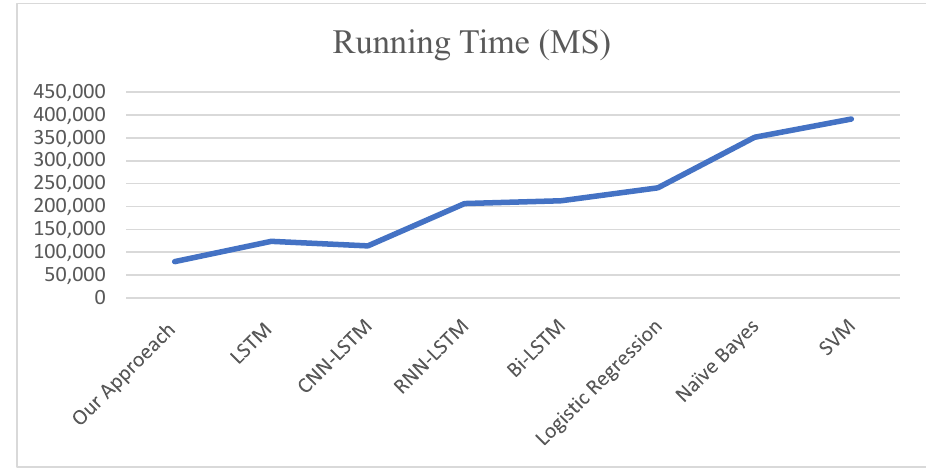
Figure 9. Illustrated time complexity for each approach. Table 4. The final results compared between (SA-CD19-EL) and other methods for the fake news dataset.